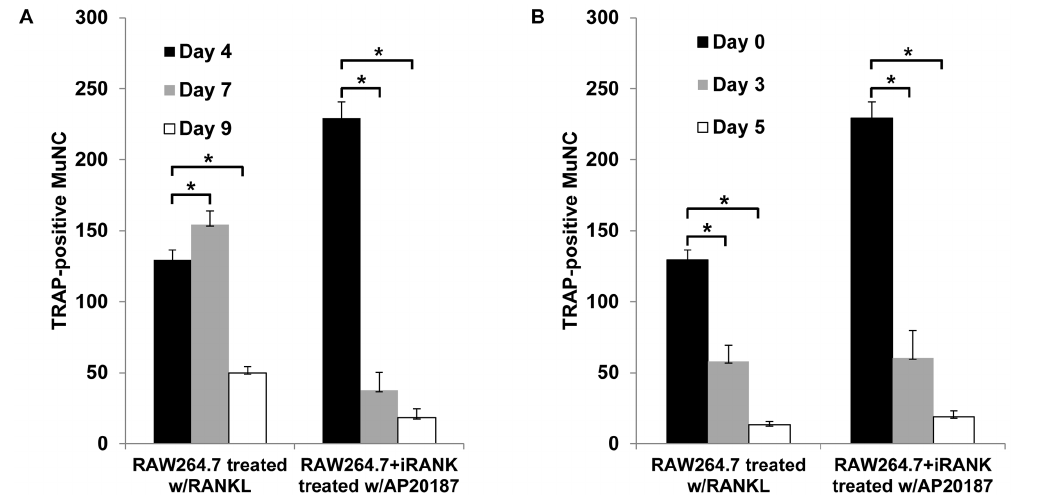
Figure 8. Cell survival study. RAW264.7 cells and RAW264.7 + iRANK cells were treated with either RANKL (40 ng/ml) or AP20187 (50 nM) for 4 days to allow osteoclasts to form. The supplemented media was removed, and cells were cultured for additional 0, 3 or 5 days in the presence (A) or absence (B) of inducers, and the number of TRAP-positive multinucleated cells (MuNC) per well was counted and averaged over 4 wells. *p , 0.05.